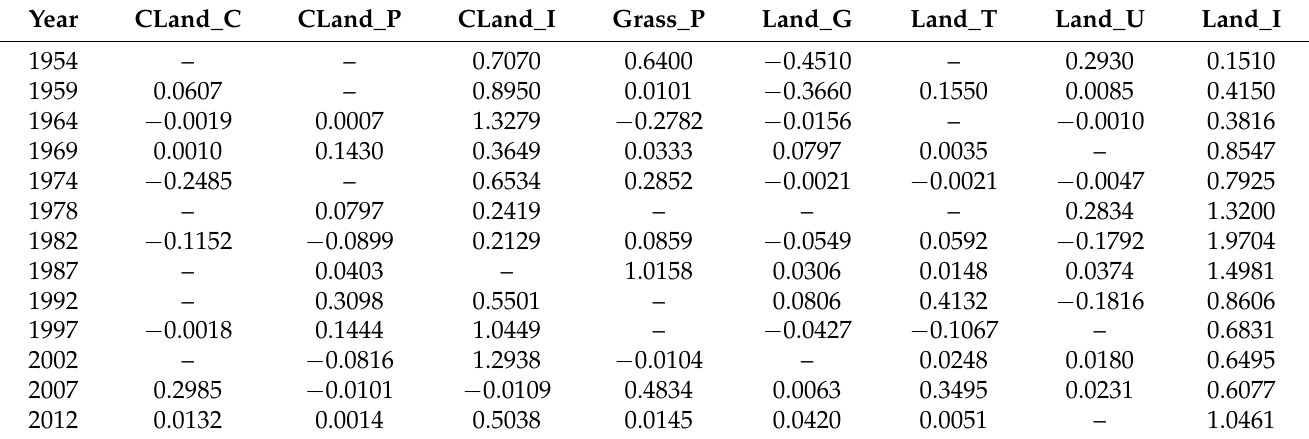
Table 10. Parameter estimates using penalty estimates via LASSO under a spatial logistic